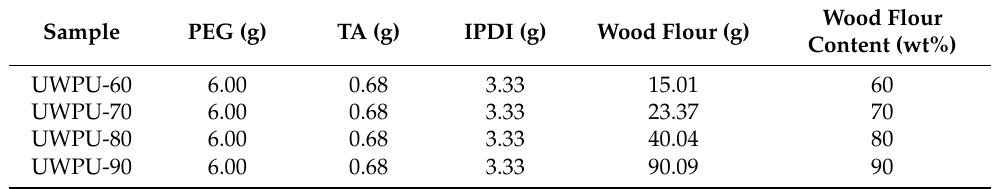
Table 1. Formulations of preparing UWPU